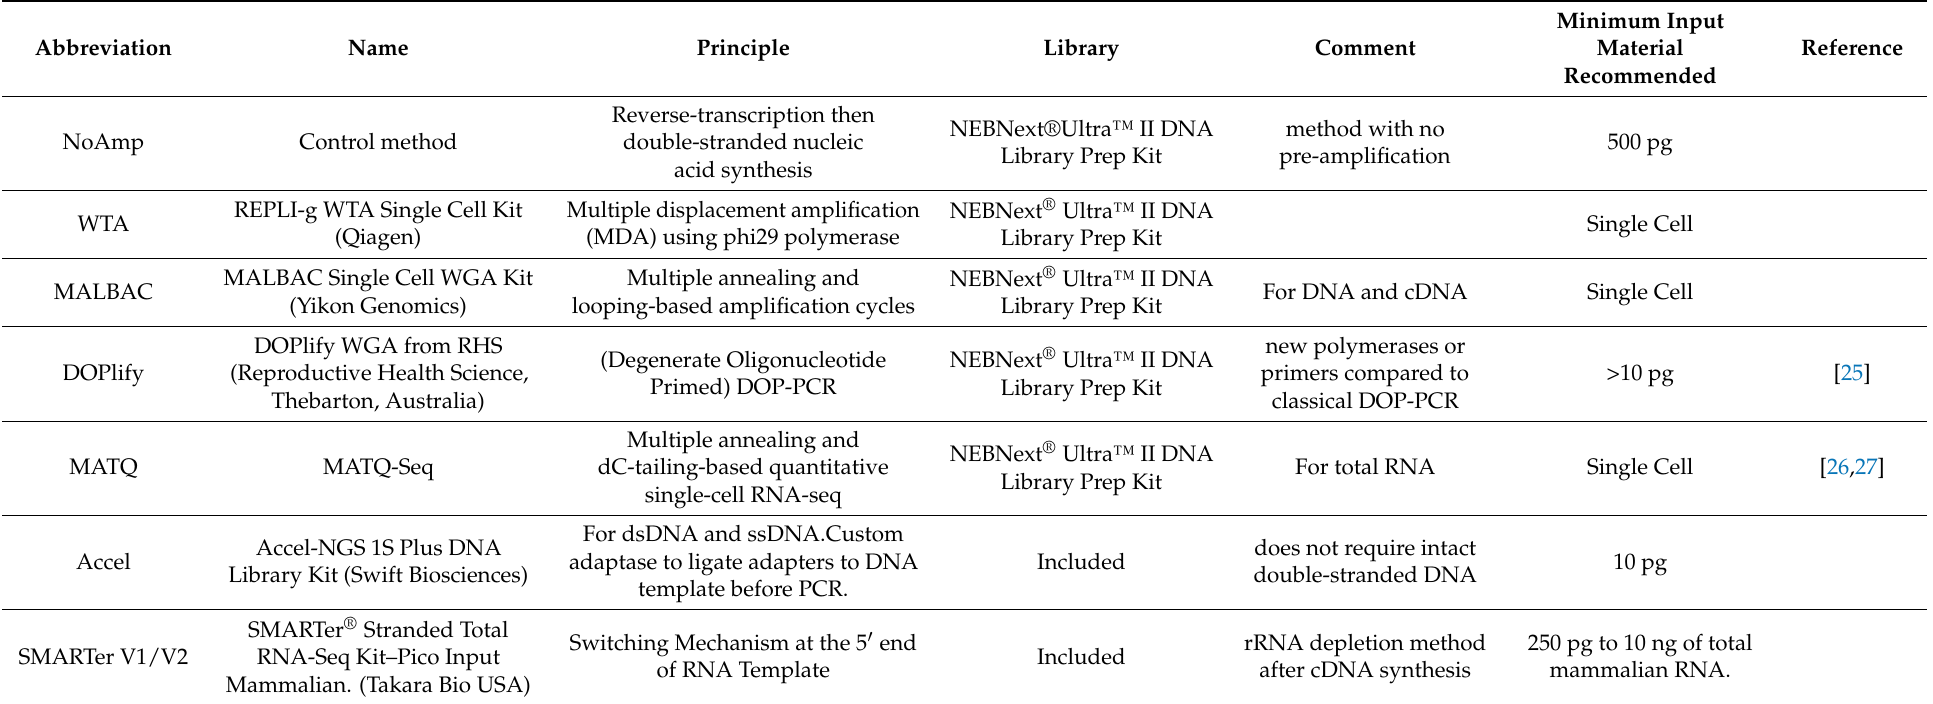
Table 1. Summary of the methods of amplification and library